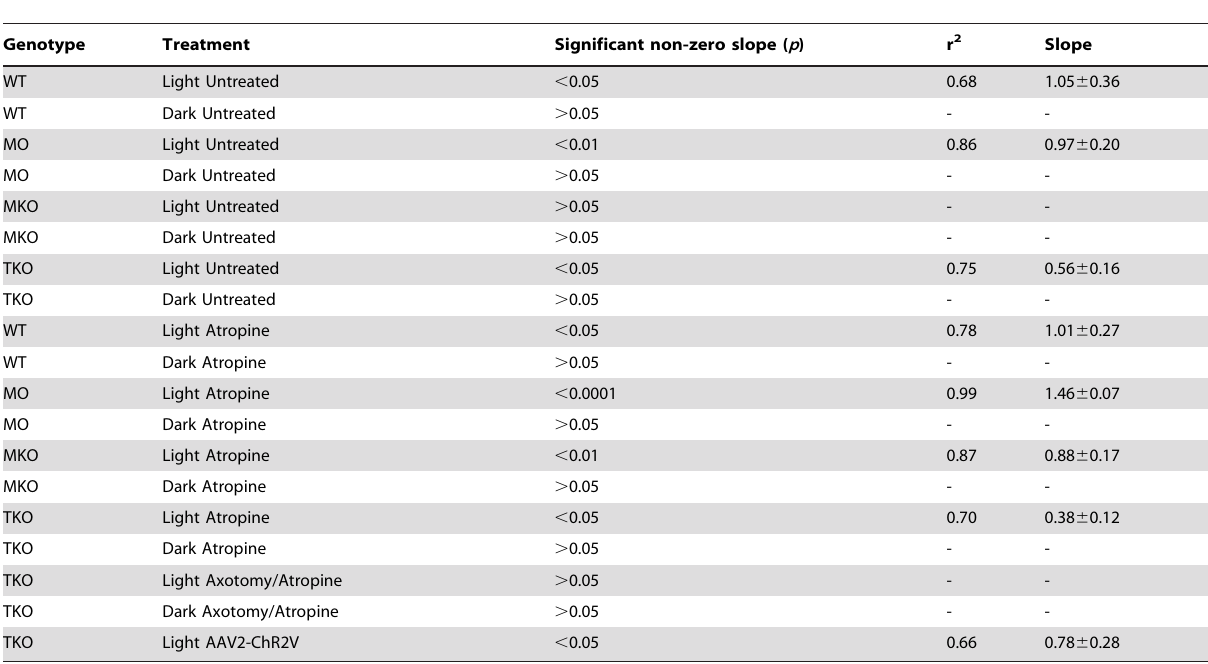
Table 1. Regression analysis of temporal kinetics of light aversion in